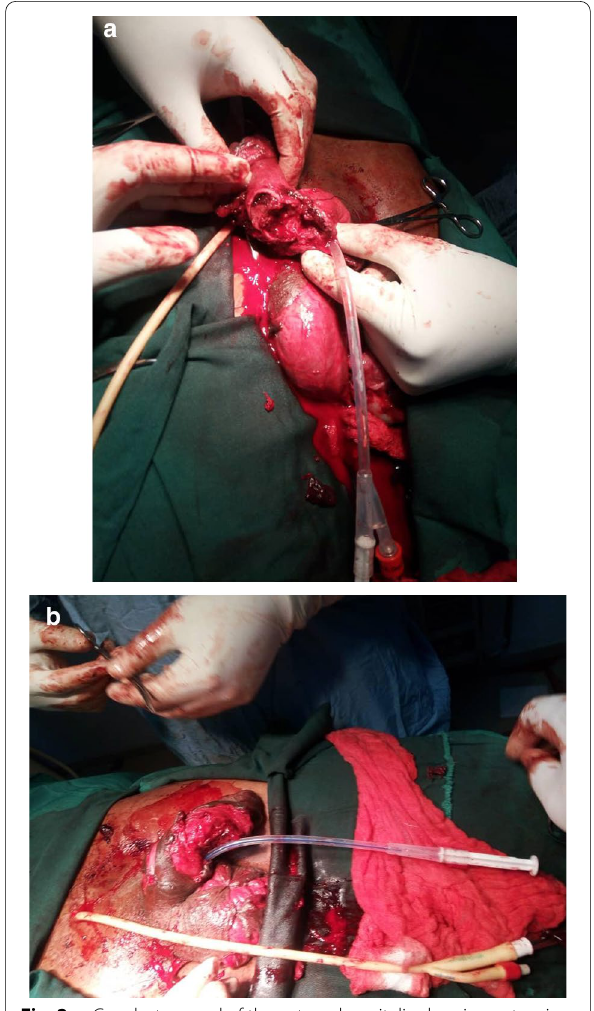
Fig. 2 a Gunshot wound of the external genitalia showing extensive urethral and corporal disruptions. b Gunshot wound of the external genitalia. Corporal disruptions have been repaired primarily. Also showing sutured scrotal lacerations after a left orchidectomy